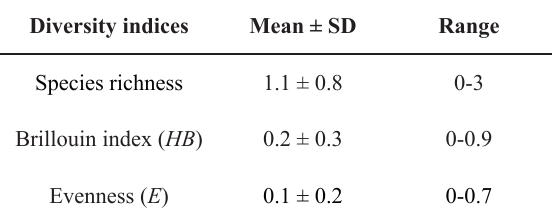
Descriptors of diversity for parasites communities of metazoan parasites of Hemibrycon surinamensis from the Matapi River, in Amapá State,